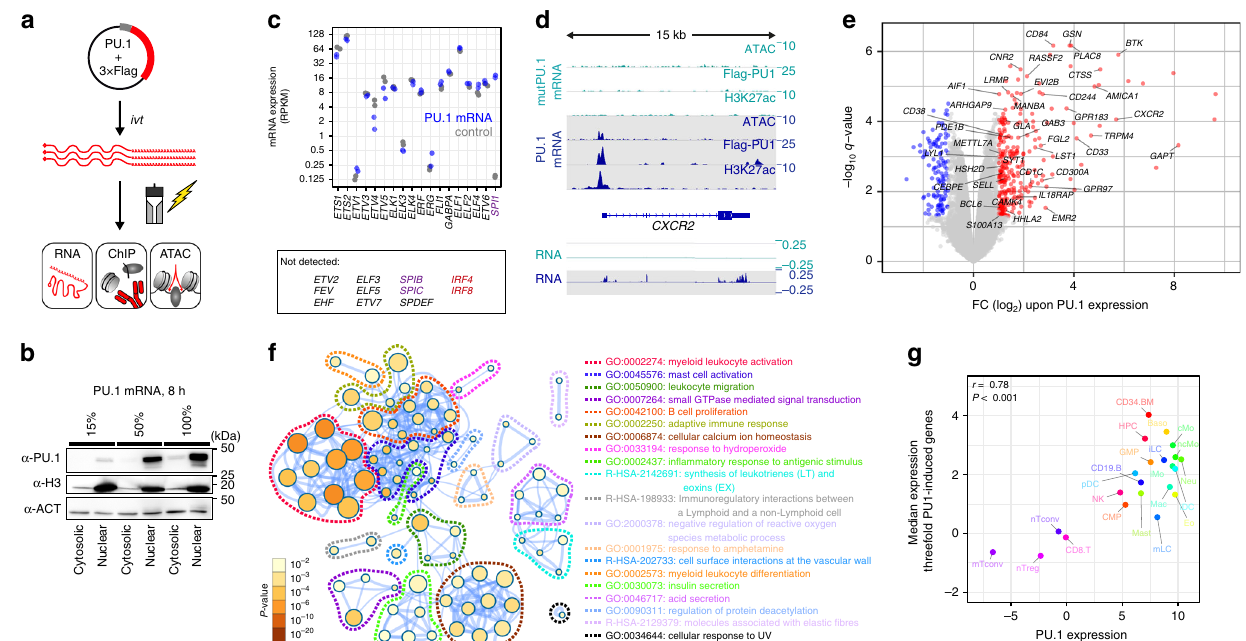
Fig. 2 Transient PU.1 expression induces a myeloid expression program. a Schematic of the experimental setup. b Immunoblotting con fi rming the translation and nuclear location of full-length PU.1 in transfected cells using increasing amounts of IVT mRNA. c Relative mRNA expression levels of ETS family members in PU.1-expressing or control cells measured by RNA-seq ( n = 2 each). d Example tracks for a PU.1-activated gene. Coverage represents the mean of n = 3 or n = 2 experiments for ATAC/ChIP-seq or RNA-seq data, respectively. e Volcano plot of signi fi cantly PU.1 up- or downregulated genes (red or blue, respectively). Genes with known function in myeloid or B-cell biology are labeled. f Metascape-derived network of Gene Ontology (GO) terms associated with PU.1-induced genes in CTV-1 cells. The signi fi cance of enrichment of a particular term is depicted with the log10 of the p -value and indicated by node coloring. g Comparison of median expression levels of PU.1-induced genes (threefold) with PU.1 expression levels across various human blood cell types data based on CAGE (Cap Analysis of Gene Expression) expression data from the FANTOM Consortium 35 . Related cell types in the hematopoietic tree share similar colors. The Pearson ’ s correlation as well as the corresponding p -value are indicated. b , c , e – g Source data are provided as a Source Data fi